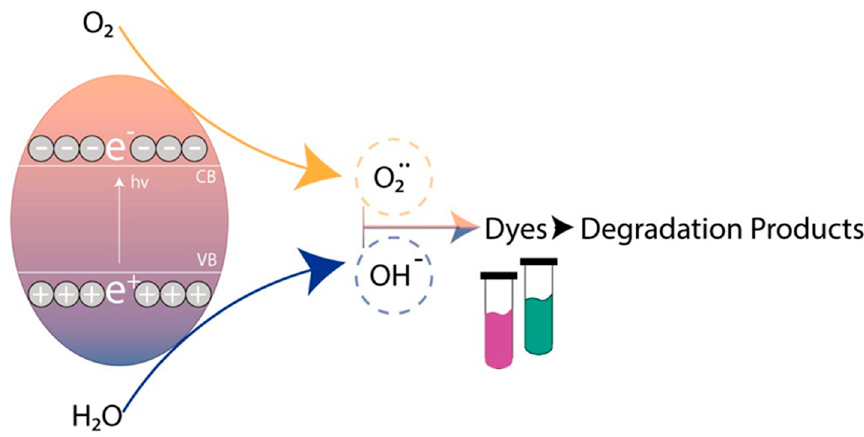
Figure 14. The reaction mechanism of the decolorization of dyes over CuFe 2 O 4 .